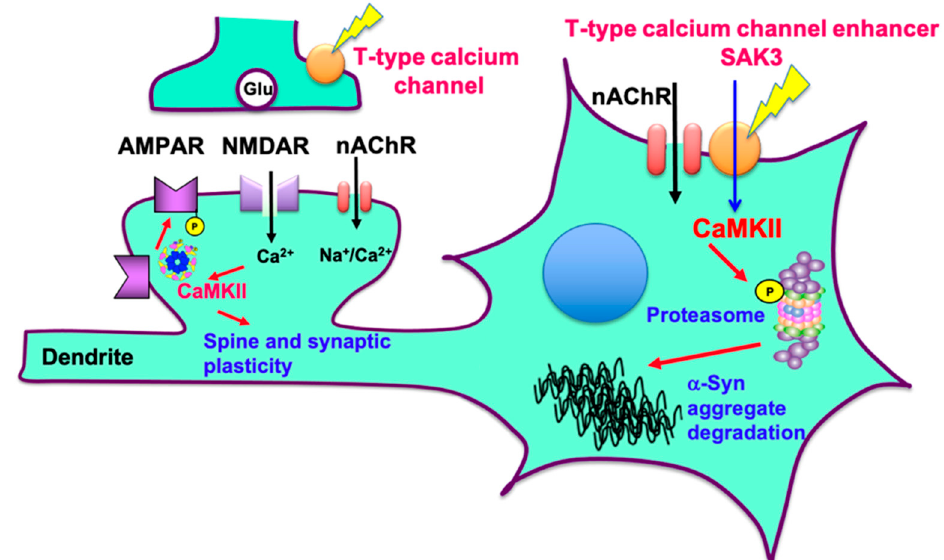
Figure 9. Schematic illustration of the action mechanism of SAK3 in PD pathology. SAK3 triggers intracellular calcium influx and promotes Glu release by enhancing T-type calcium channels. Proteasome activity is increased via the CaMKII/Rpt6 signaling pathway. Facilitated proteasomal activity by SAK3 contributes to the degradation of α -Syn aggregates and potentiates synaptic plasticity. AMPAR, glutamate α -amino-4-hydroxy-5-methyl-4-isoxazolepropionic acid receptor; NMDAR, glutamate N-methyl-D-aspartate receptor; nAChR, nicotinic acetylcholine receptor.